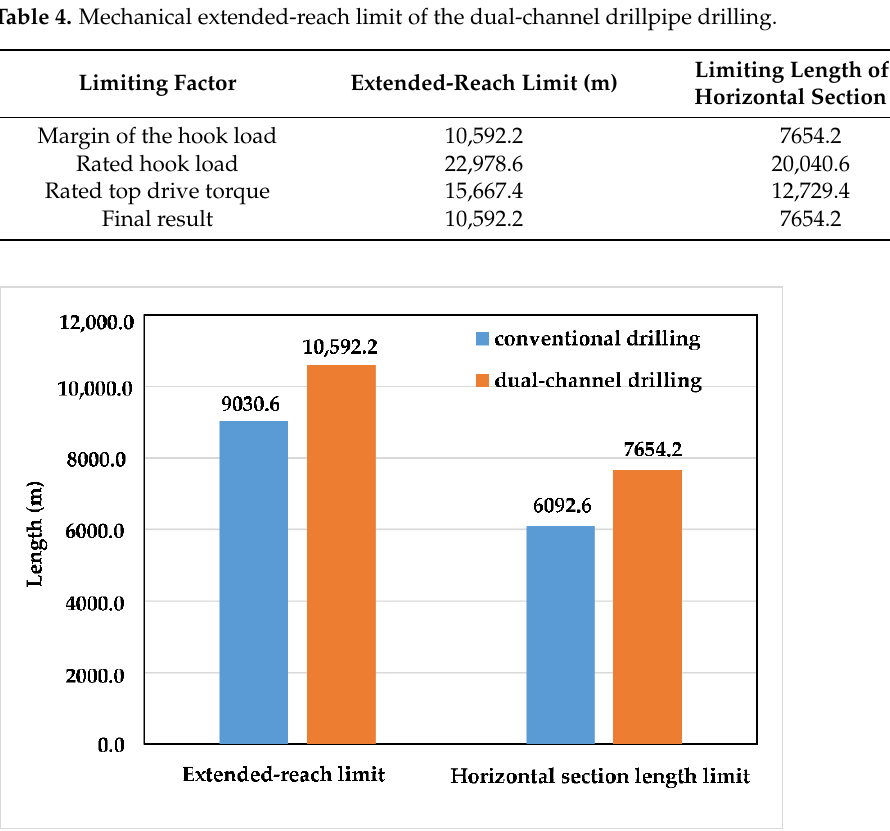
Figure 6. Comparison of conventional drilling to dual-channel drillpipe drilling.